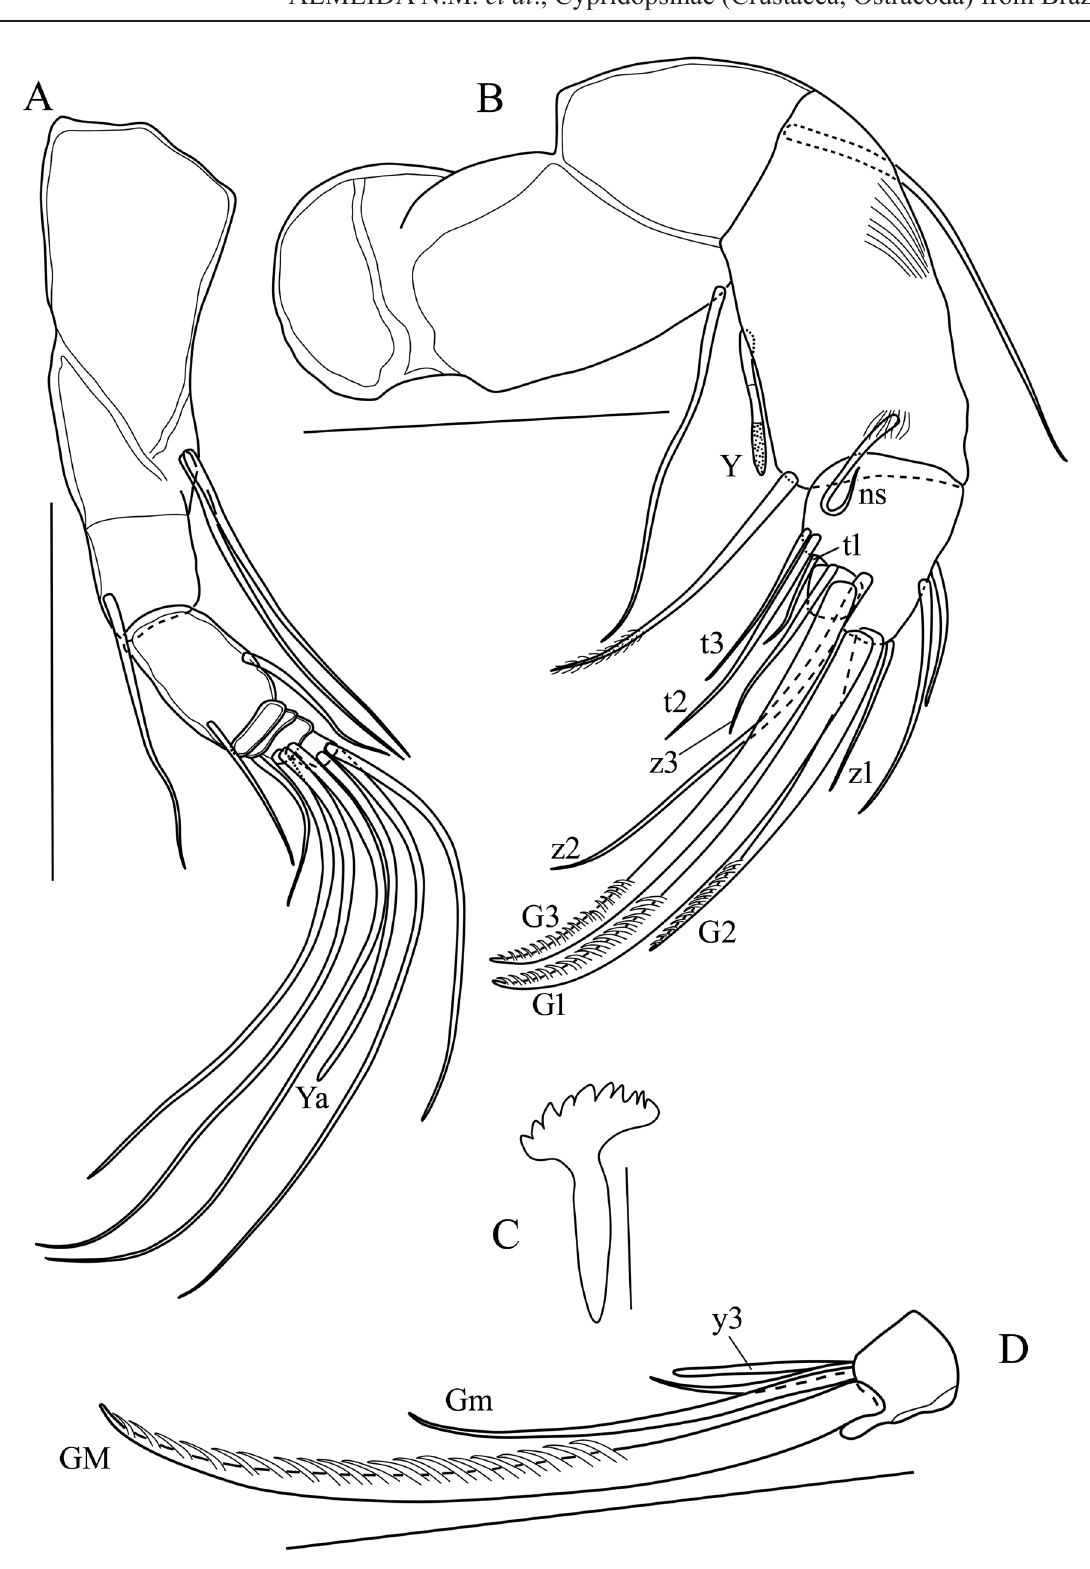
Fig. 19. Paranadopsis reducta gen. et sp. nov. from the Upper Paraná River floodplain, ♀. A . A1 (MZUSP 41866). B . A2, without the terminal segment (MZUSP 41868). C . Rake-like organ (MZUSP 41869). D . A2, terminal segment (MZUSP 41868). Abbreviations: see text and Material and methods. Scale bars: A–B, D = 50 µm; C = 10